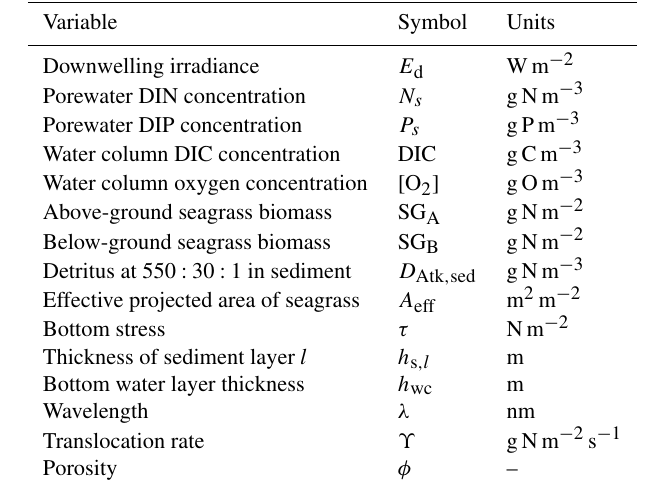
Table 21. State and derived variables for the seagrass model. For simplicity, in the equations, all dissolved constituents are given in grams, although elsewhere they are shown in milligrams. The bottom water column thickness is spatially variable depending on